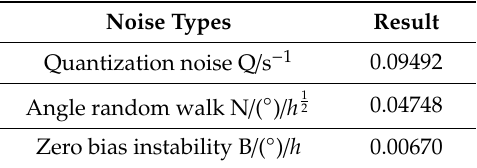
Figure 4. X-axis Allan analysis of variance of the MEMS gyroscope. Table 1. X-axis values of the parameters Allan variance.